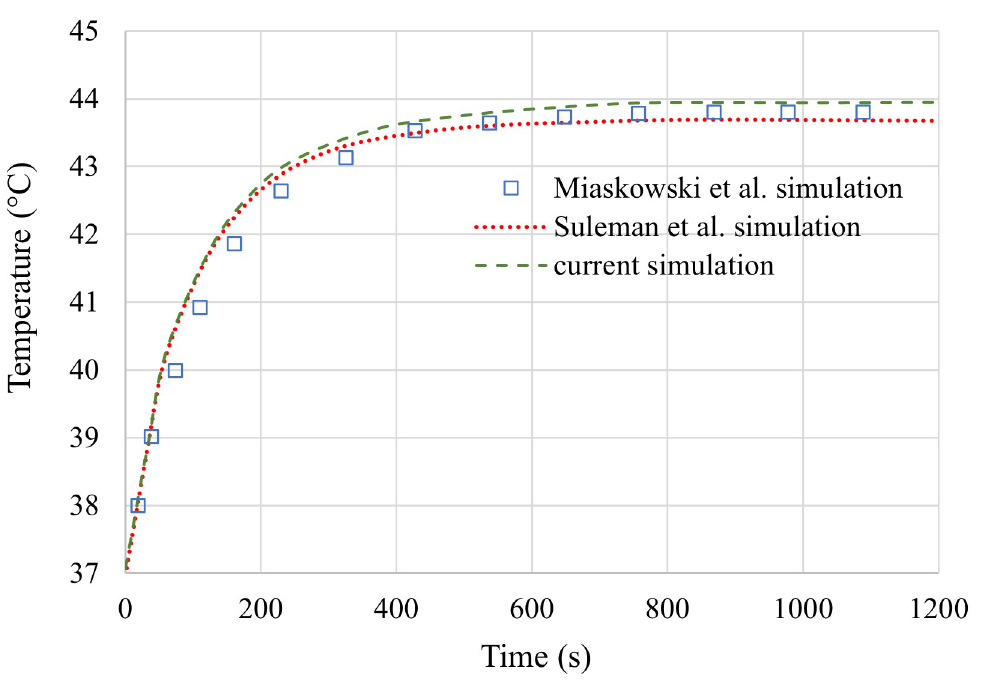
Fig 11. Comparison among current simulation, Suleman et al. simulation, and Miaskowski simulation plots of the maximum temperature in the breast model versus time.